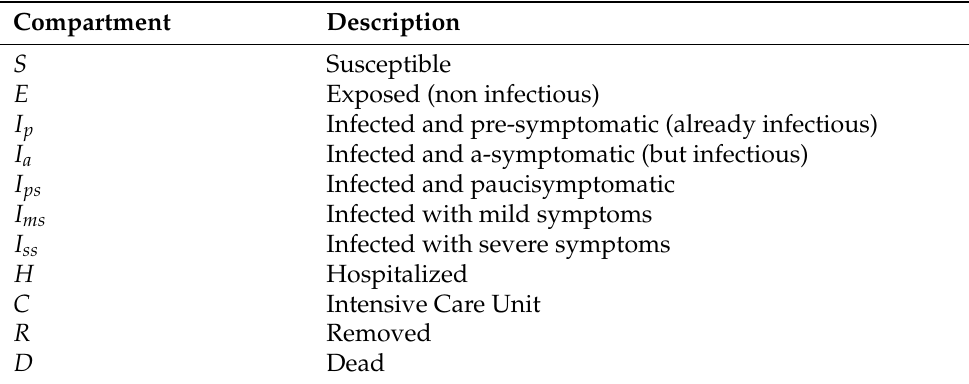
Table 1. Description of the compartments in Model SEI 5 CHRD .